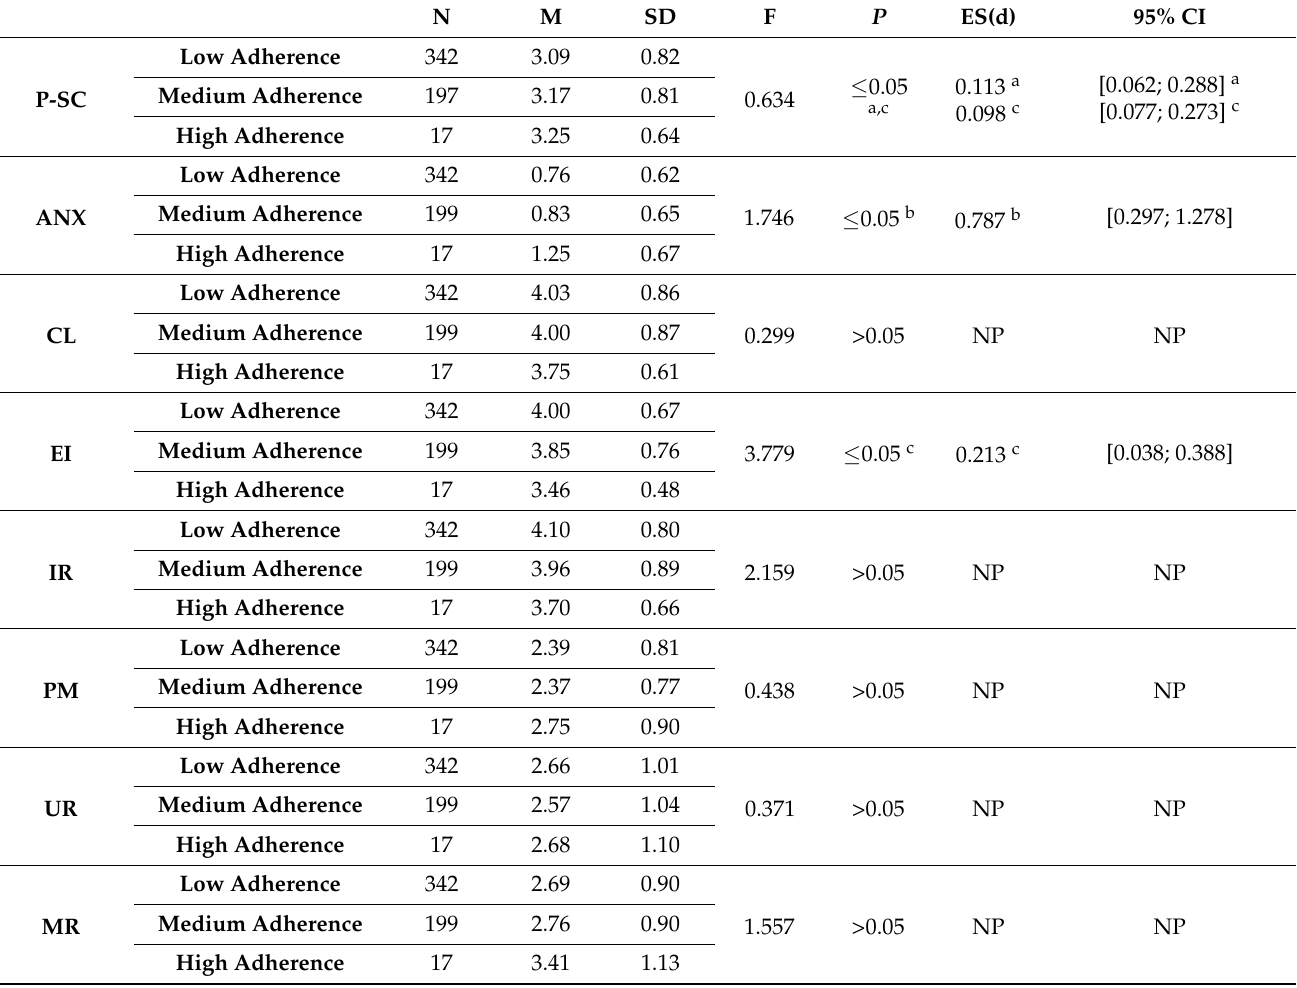
Table 1. Comparative Study of the Sample.